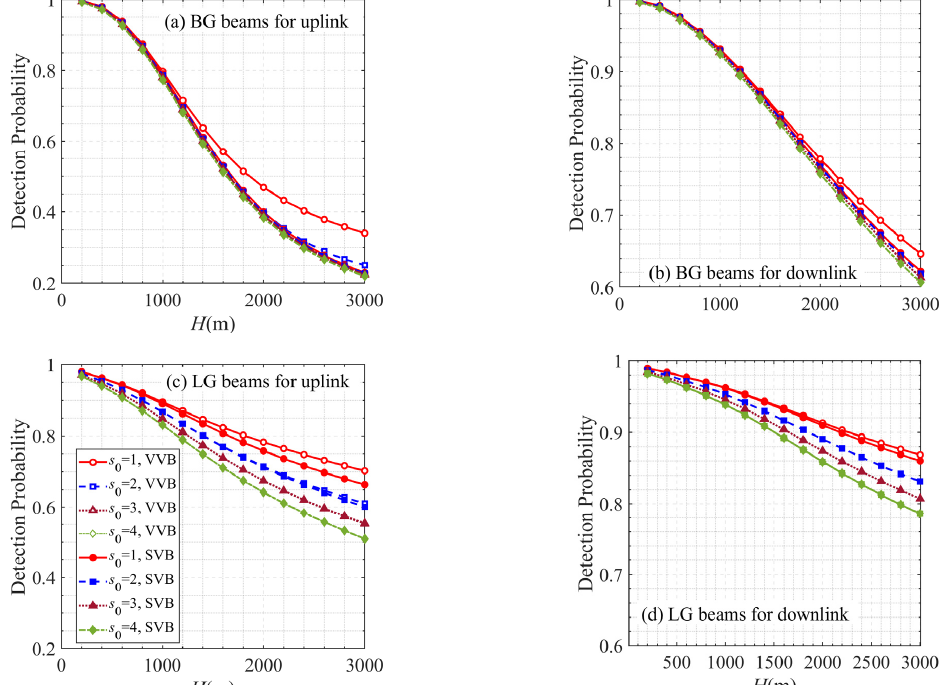
Figure 4. Signal mode detection probability of vector and scalar vortex beams versus H with different s 0 for uplink ( a , c ) and downlink ( b , d ) atmospheric turbulence transmissions. ( a , b ) and ( c , d ) adopt BG and LG beams as the source. VVB and SVB represent vector and scalar vortex